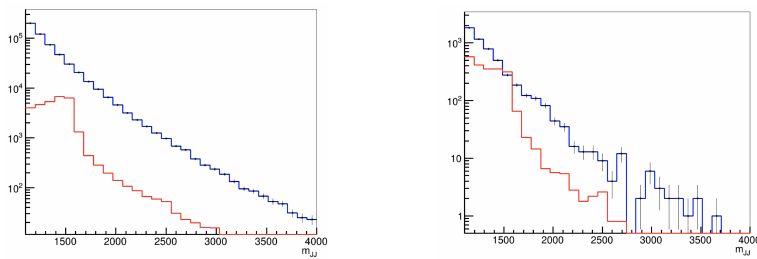
Figure 9. G RS → WW broad benchmark with σ = 40pb: Dijet mass spectrum before VAE cut (left) and dijet mass spectrum after VAE cut